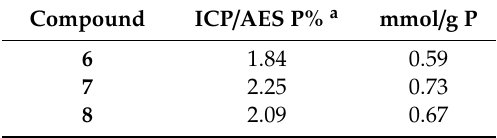
Table 1. Content of phosphorus calculated using ion plasma atomic emission spectroscopy (ICP-AES). Compound